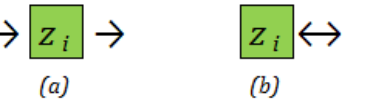
Figure 1. Deadlock-free zones: ( a ) A standard type. ( b ) A new